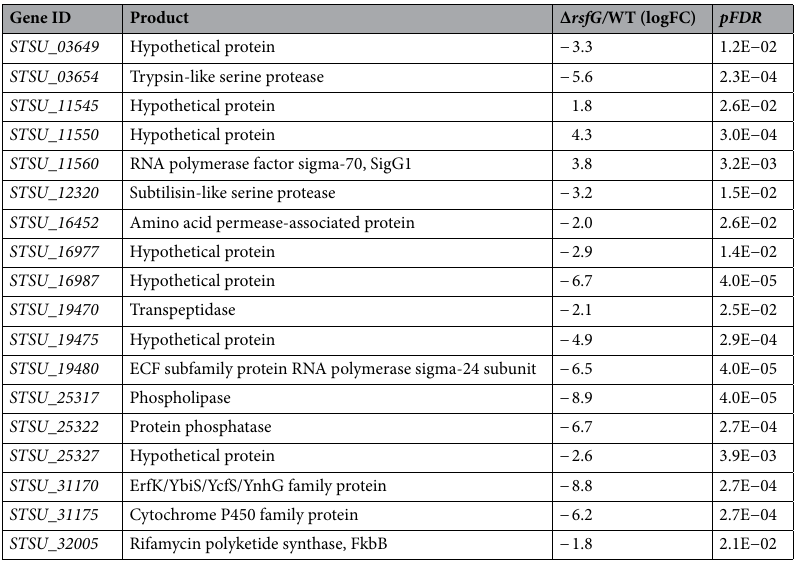
Table 2. rsfG -dependent genes identified by RNA-seq analysis (FDR < 0.05). Volcano plot available in Supplementary Fig. S5 FDR false discovery rate, FC fold